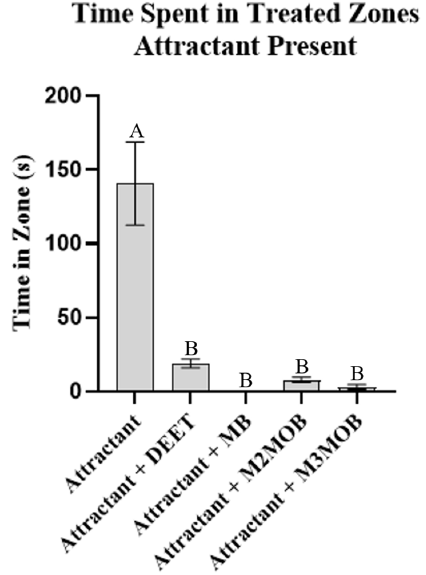
Figure 4. Repellent activity in presence of aggregation pheromone components. Amount of time (mean +/ − SEM) the subject spent in zone treated with attractant [equal parts by volume of ( E )-2- hexenal and ( E )-2-octenal, diluted 1:10,000 (0.01%) in acetone] and repellent [DEET, methyl benzoate (MB), methyl 2-methoxybenzoate (M2MOB), or methyl 3-methoxybenzoate (M3MOB)]. Different letters above them are significantly different at α = 0.05. ANOVA: n = 20 per treatment ( n = 100 total), F(4, 95) = 22.37, p < 0.0001. Holm-Šid á k’s multiple comparisons: Control vs. any other treatment, p < 0.0001; all other comparisons not